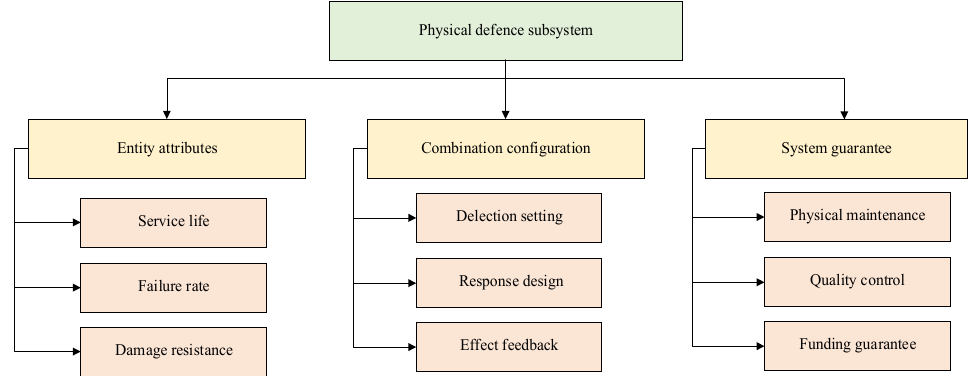
Figure 8. Measurement framework of the physical defence system capability indicator.